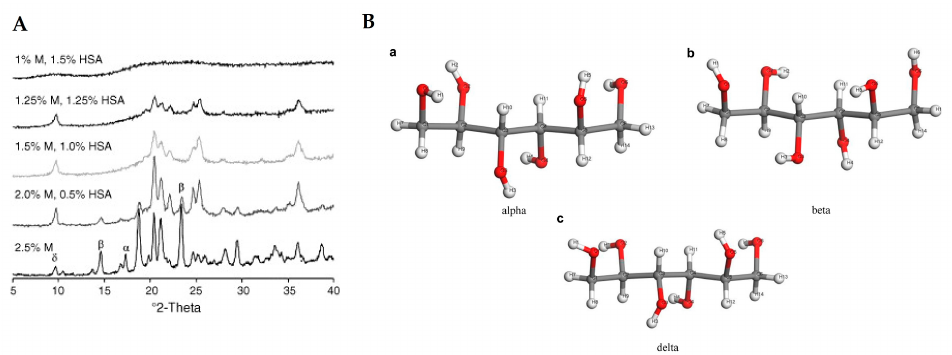
Figure 13. XRD analysis of lyophilized human serum albumin (HSA) formulations with different amounts of mannitol (M) is depicted in figure ( A ). Reproduced with permission from [153], Elsevier, 2006. In figure ( B ) the three forms of mannitol (a—alpha, b—beta and c—delta) are depicted in structural arrangements. Reproduced with permission from [154], Elsevier, 2020.